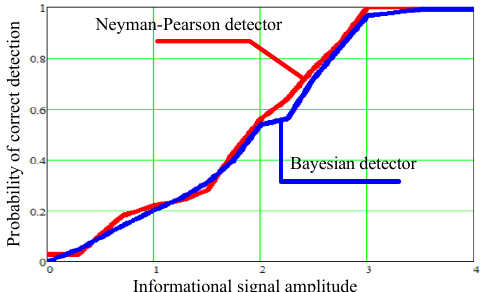
Fig. 10. The operating characteristics for two algorithms of